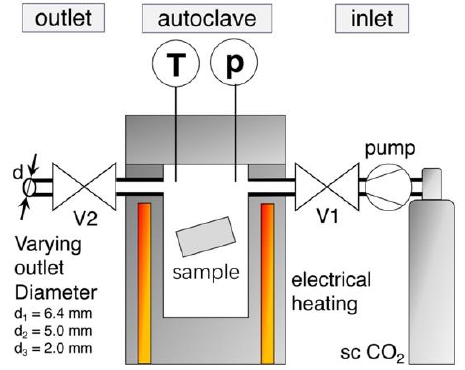
Figure 1. Sketch of foaming set up with the custom-made autoclave.